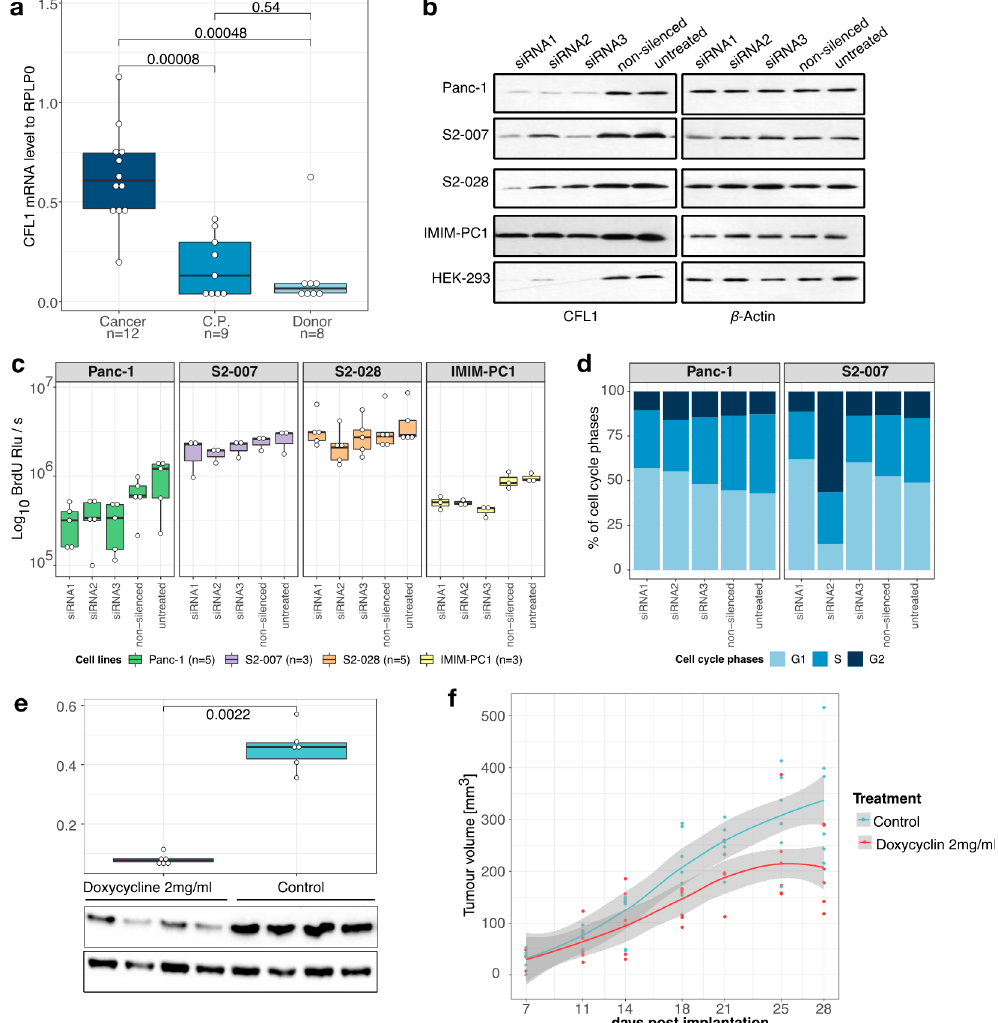
Figure 1. CFL1 in pancreatic cancer. ( a ) Quantitative real-time polymerase chain reaction (qRT-PCR) analyses showed overexpression of CFL1 mRNA in tissue samples of pancreatic ductal adenocarcinoma (Cancer, n = 12) compared to chronic pancreatitis (C.P., n = 9) or healthy donor (Donor, n = 8) pancreas tissues. ( b ) CFL1 knockdown was performed by three independent siRNAs in four pancreatic cancer cell lines (Panc-1, S2-007, IMIM-PC1, and S2-028) and one control cell line (HEK-293). CFL1 knockdown was confirmed on the protein level (left panel). β -actin was used as an equal loading control (right panel). ( c ) BrdU incorporation assays were performed 48 h after the transfection of three independent siRNAs and relative light units per second (Rlu/s) were measured. The number of samples ( n ) represents biological replicates. ( d ) Panc1 and S2-007 cells were propidium-iodide-stained 48 h post-transfection with CFL1-specific or non-silencing siRNAs and subjected to flow cytometric analysis. Both cell lines treated with siRNA1 or siRNA3 show a decrease of cells in S-phase accompanied by an increase of cells in the G1 phase. S2-007 cells transfected with siRNA2 show a dramatic increase of cells in the G2 phase, consistent with G2/M phase arrest. Results depict the average of three independent experiments. ( e ) S2-007 cells with doxycycline-inducible CFL1 knockdown were injected into nude mice. One-half of the mice ( n = 6) were treated with doxycycline via drinking water to induce CFL1 repression. After the removal of the tumors RNA and protein were extracted from tissues and analyzed for the CFL1 level. Quantitative RT-PCR as well as western blots confirmed repression of CFL1 in the treatment group. β -Actin served as a loading control and mean values of expression were normalized to RPLP0 housekeeping gene. Statistics were performed using Wilcoxon-test. ( f ) Tumor size measurements revealed a significant decrease in tumor growth in doxycycline-treated animals ( n = 6) compared to controls ( n = 6). All mice developed tumors. Displayed are data points with a smoothing line and the corresponding confidence interval. Boxplots depict the median with the first and third